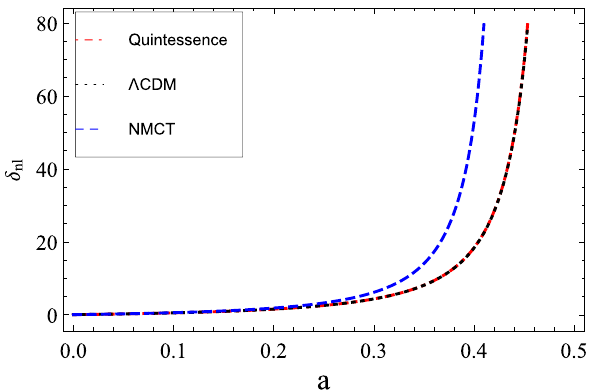
Fig. 5 The non-linear evolution of overdensity parameter δ nl versus the scale factor for the Λ CDM , quintessence and NMCT models